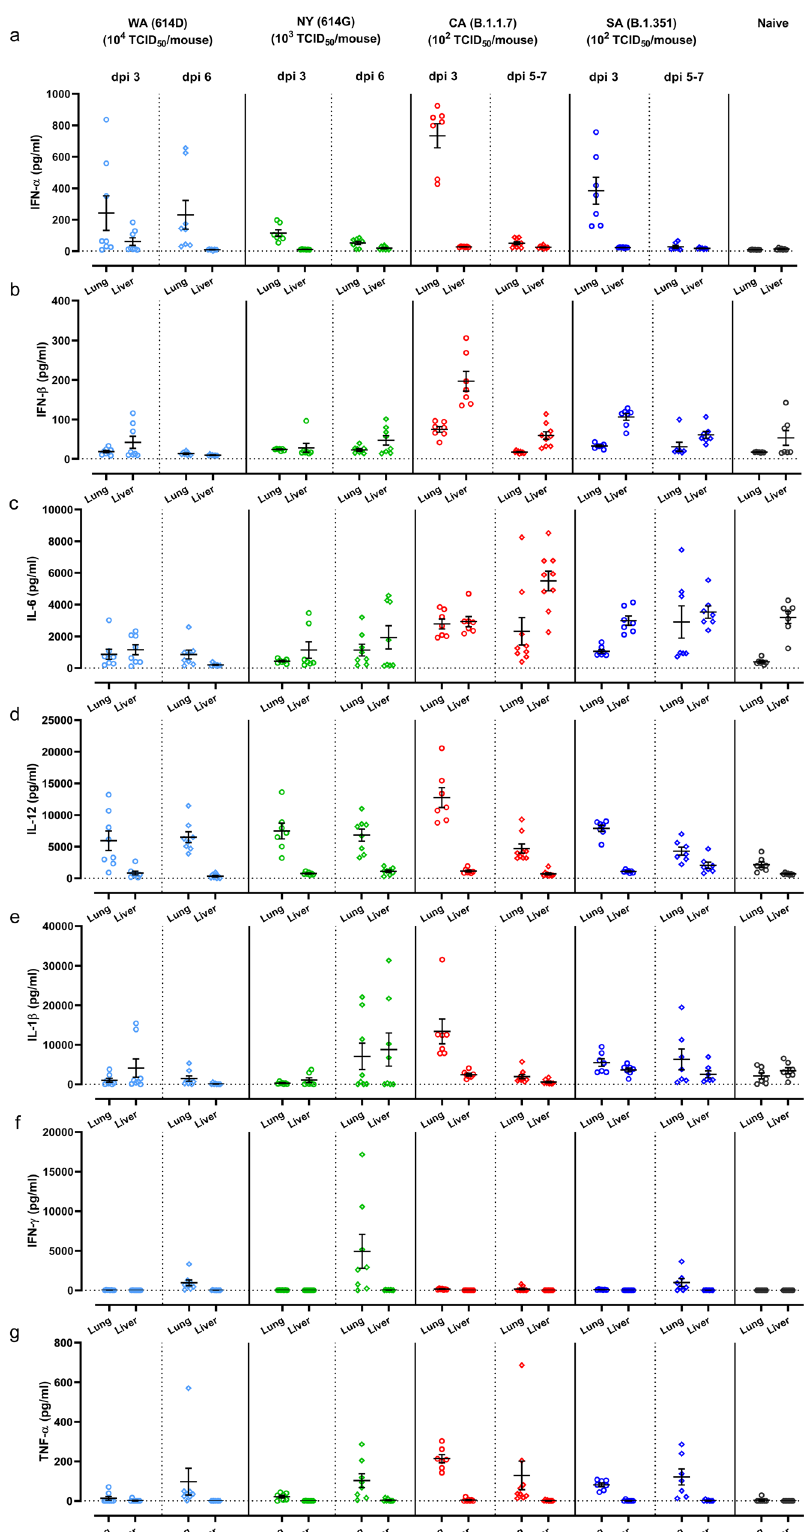
scores for D-dimer in lung, liver and brain were 1.17, 0.61 and 1.12, respectively, all pointing to the cluster of CA/SA infections (Fig. 8d). These results suggest tissue-speci fi c D-dimer levels in lung, brain, and liver (at a lesser extent) were critical to distinguish infection of CA (B.1.1.7) or SA (B.1.351) variant from